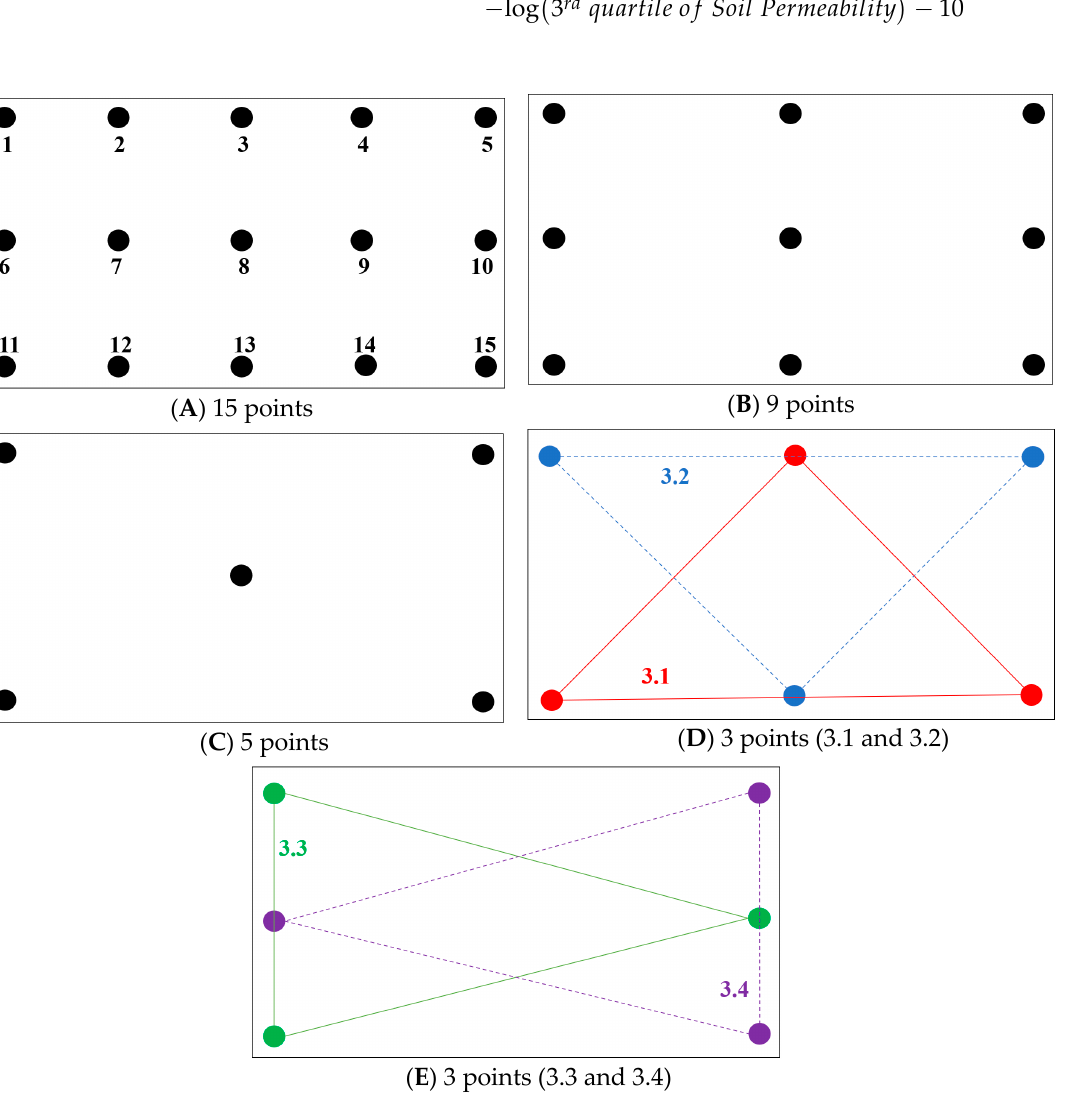
Figure 1. The measurement scheme depending on the number of points for each location ( A —15 points, B —9 points, C —5 points, D —3 points (3.1 and 3.2), E —3 points (3.3 and